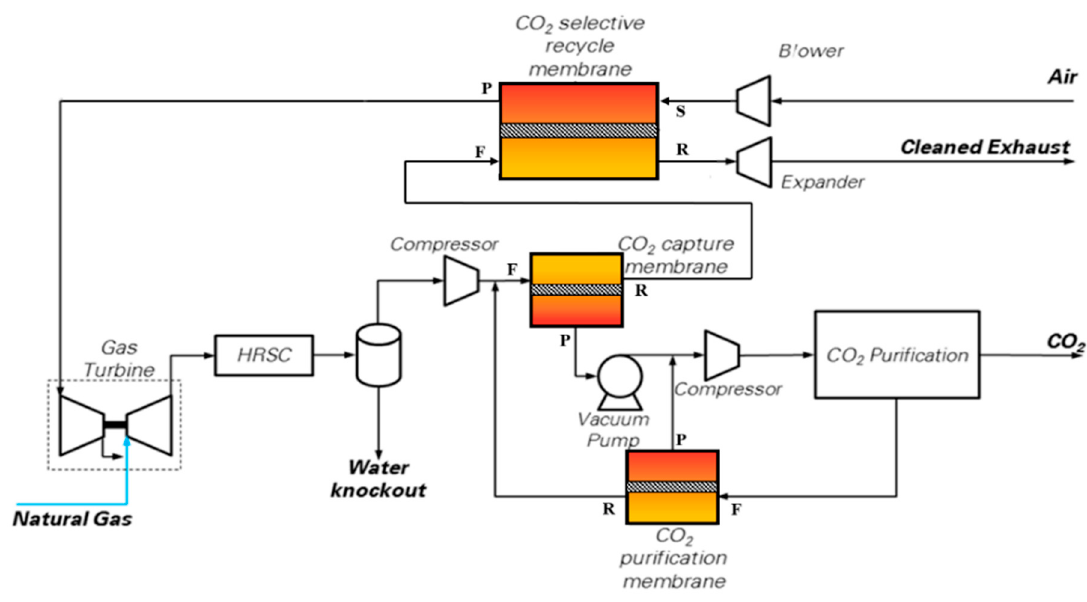
Figure 3. CO 2 capture scheme using CO 2 permeable membranes. Nomenclature of membrane inlet / outlet streams: F = Feed; P = Permeate; R = Retentate; S = Sweep.